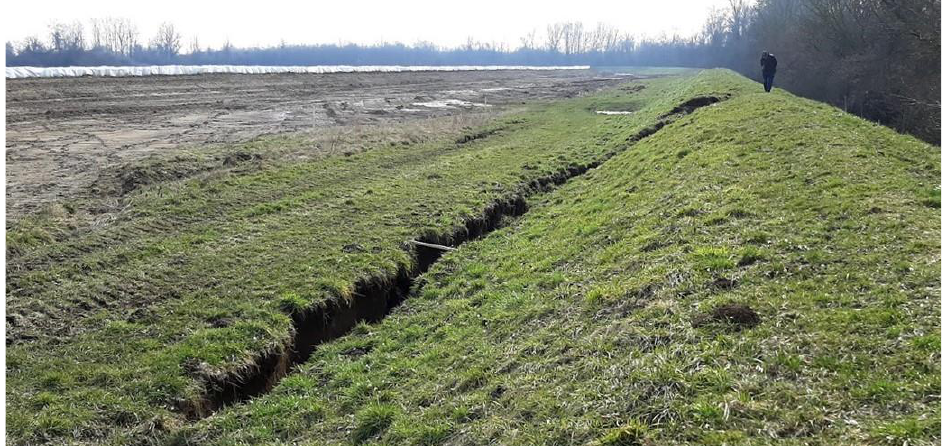
Figure 7. Embankment near Stara Drenčina. The crack crosses the embankment and causes subsid- ence. A white secondary embankment is visible.